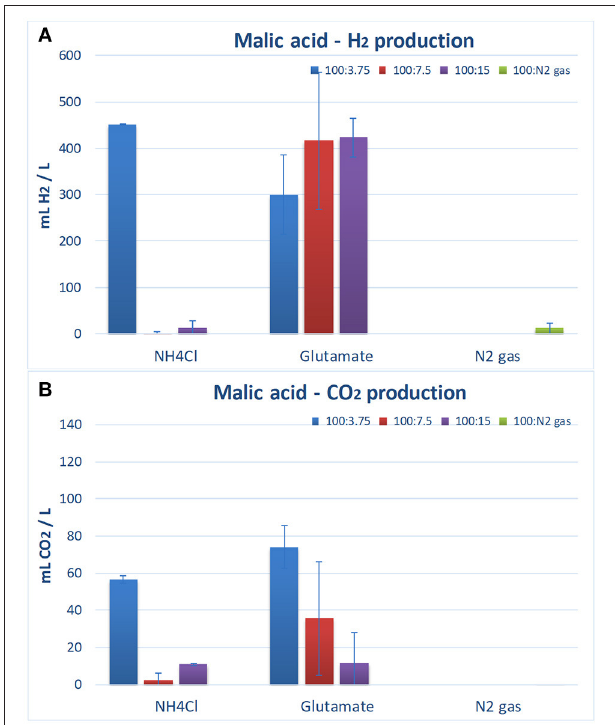
FIGURE 3 | Hydrogen (A) and CO 2 (B) production by the PPB biological activity after 1 week of reaction with different nitrogen substrates and malic acid as organic carbon source. Error bars are standard deviations from triplicate